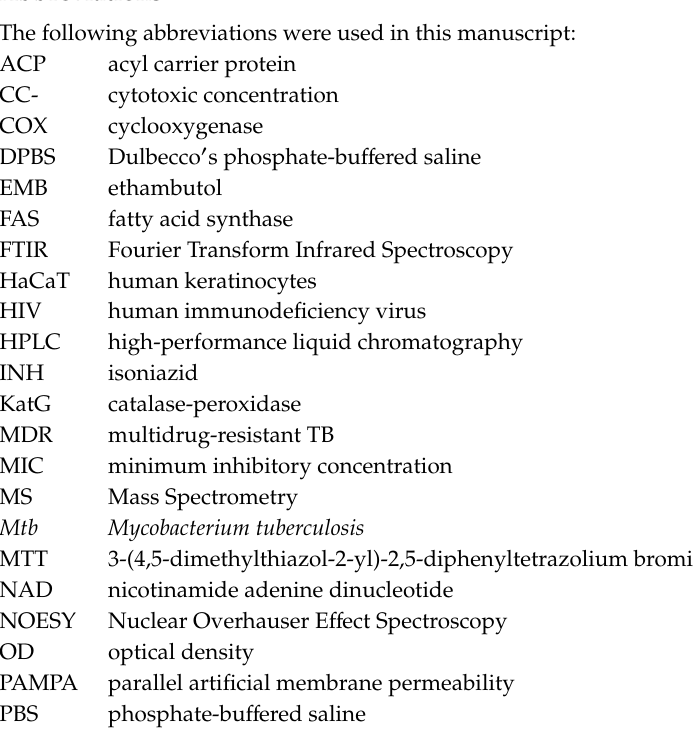
of compound 20 . Figure S47. HPLC analysis of compound 20 . Figure S48. 1 H NMR spectrum of compound 21 . Figure S49. 13 C NMR spectrum of compound 21 . Figure S50. 11 B NMR { 1 H BB} spectrum of 21 . Figure S51. IR spectrum of compound 21 . Figure S52. MS spectrum of compound 21 . Figure S53. HPLC analysis of compound 21 . Figure S54. 1 H NMR spectrum of compound 22 . Figure S55. 13 C NMR spectrum of compound 22 . Figure S56. 11 B NMR { 1 H BB} spectrum of compound 22 . Figure S57. IR spectrum of compound 22 . Figure S58. MS spectrum of compound 22 . Figure S59. HPLC analysis of compound 22 . Figure S60. 1 H NMR spectrum of compound 23 . Figure S61. 13 C NMR spectrum of compound 23 . Figure S62. 11 B NMR { 1 H BB} spectrum of compound 23 . Figure S63. IR spectrum of compound 23 . Figure S64. MS spectrum of compound 23 . Figure S65. HPLC analysis of compound 23 . Figure S66. 1 H NMR spectrum of compound 24 . Figure S67. 13 C NMR spectrum of compound 24 . Figure S68. 11 B NMR { 1 H BB} spectrum of compound 24 . Figure S69. IR spectrum of compound 24 . Figure S70. MS spectrum of compound 24 . Figure S71. HPLC analysis of compound 24 . Figure S72. 1 H NMR spectrum of compound 25 . Figure S73. 13 C NMR spectrum of compound 25 . Figure S74. 11 B NMR { 1 H BB} spectrum of compound 25 . Figure S75. IR spectrum of compound 25 . Figure S76. MS spectrum of compound 25 . Figure S77. HPLC analysis of compound 25 . Table S1. Crystallographic data. General procedure for competitive trapping. Figure S78. The resulting trapped product O -isonicotinoylhydroxylamine ( 26 ). Figure S79. MS spectrum of reaction of INH with TEMPO and manganese catalyst. Figure S80. MS spectrum of reaction of 8 with TEMPO and manganese catalyst. Figure S81. MS spectrum of reaction of 21 with TEMPO and manganese catalyst. Figure S82. MS spectrum of reaction of 25 with TEMPO and manganese catalyst. Figure S83. Confirmation of mutant construction by Southern blotting